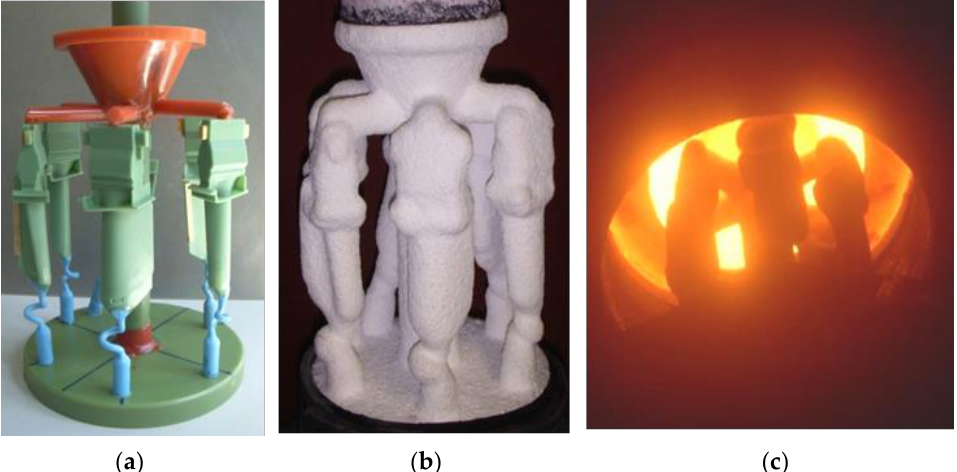
Figure 2. ( a ) Wax pattern cluster; ( b ) shell mold cluster; ( c ) withdrawal of poured mold in Bridgman furnace.